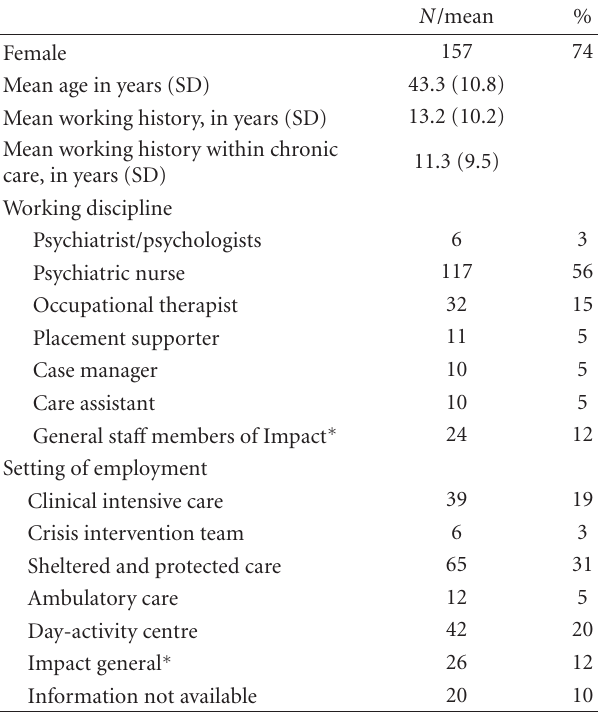
Table 1: Demographic characteristics of the study group ( n =